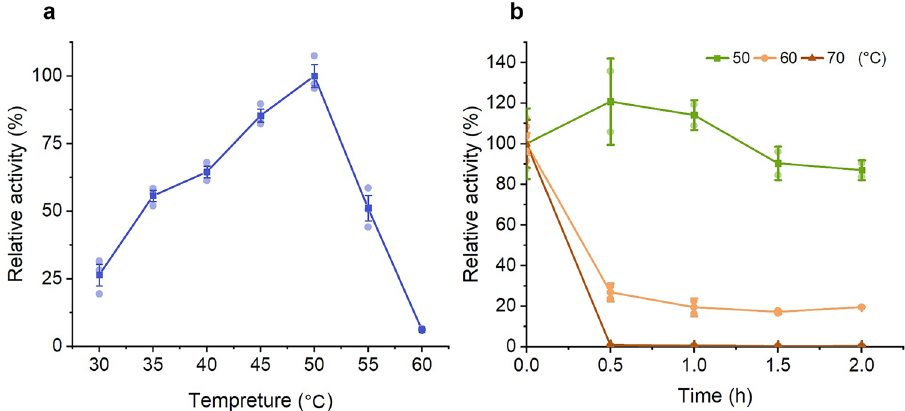
Fig. 1 The optimum temperature of partial-deglyco Is PETase- Pp and the effect of the temperature on the stability of partial-deglyco Is PETase- Pp . a The optimum temperature of partial-deglyco Is PETase- Pp . The enzyme activity at 50 °C was set to 100%. b The effect of the temperature on the stability of partial-deglyco Is PETase- Pp . The activity of the enzyme without treatment was set to 100%. Data are presented as mean